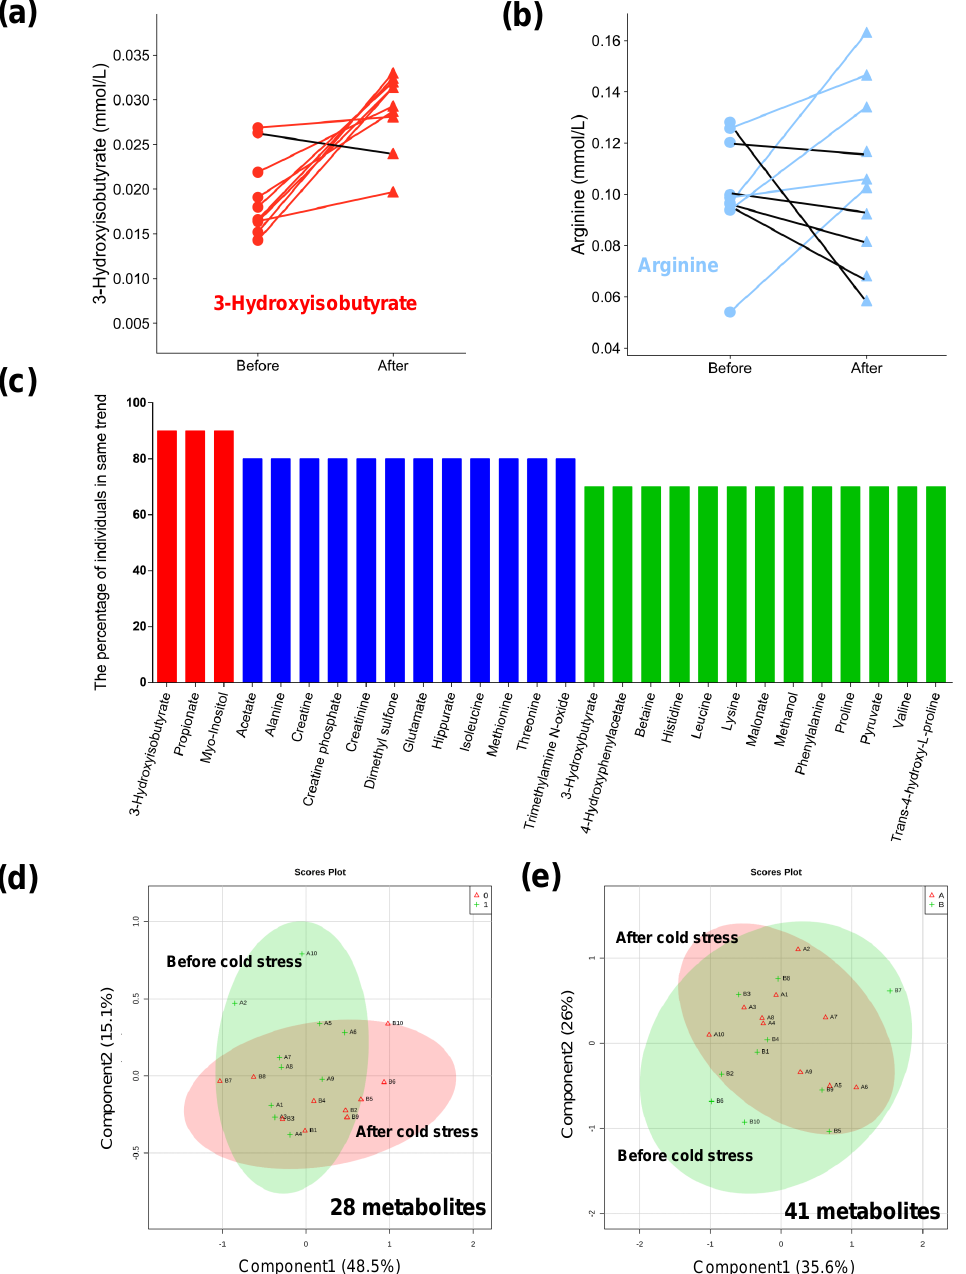
Figure 4. The pre-selection of metabolic profiling. ( a ) The changes of 3-hydroxyisobutyrate in 10 animals exposed to severe cold. ( b ) The changes of arginine in 10 animals exposed to severe cold. ( c ) Twenty-eight metabolites changed in the same trend after cold stress. ( d ) Score plots of PCA with 28 metabolites (R 2 X = 0.636). ( e ) Score plots of PCA with 41 metabolites (R 2 X =